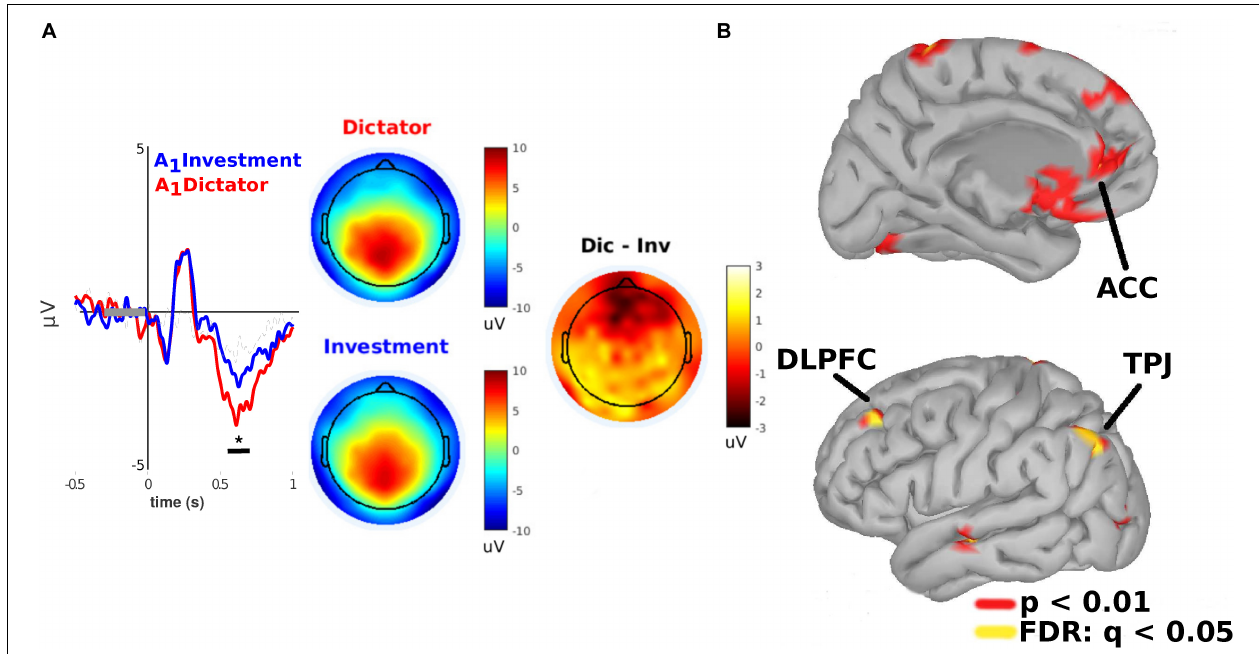
FIGURE 3 | Frontomedial negativity (FMN) is greater under DG condition than under IG condition when subjects are notified about the allocation they will receive (A1). (A) Left : ERPs amplitude ( Y -axis) of subjects when they received an allocation from a human (blue lines) versus a COM (red lines). Statistically significant differences occurred between 550 and 680 ms ( X -axis) after stimulus onset. Right: Scalp potentials distribution. (B) Cortical source projections (FDR: q < 0.05; p < 0.01, uncorrected). *indicates p <